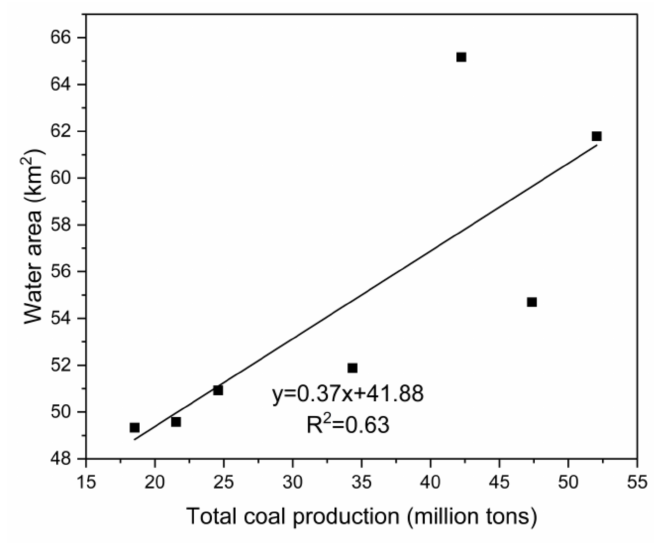
Figure 7. The relationship between total coal production and water land.